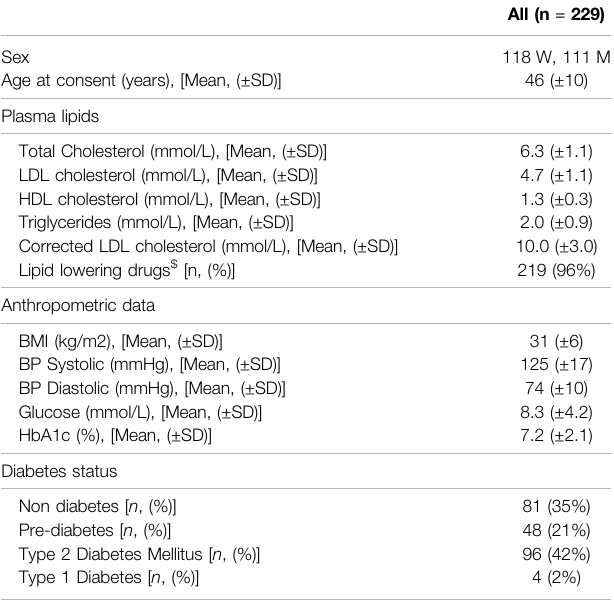
Legendandabbreviations:LDL-c,low-densitylipoproteincholesterol;HDL,high-density lipoprotein cholesterol; LDL-c plasma levels were calculated using Friedewald ’ s formula (Friedewaldetal.,1972);SD,standarddeviation;BMI,bodymassindex;$,lipid-lowering medication includes atorvastatin, Rosuvastatin or Simvastatin and/or Ezetimibe; Correction factors can be found in Supplementary Table S1 ; BP, blood pressure; HbA1c, glycated haemoglobin; On the basis of current ADA criteria (American Diabetes Associa,2018),patientspresentingHbA1c <